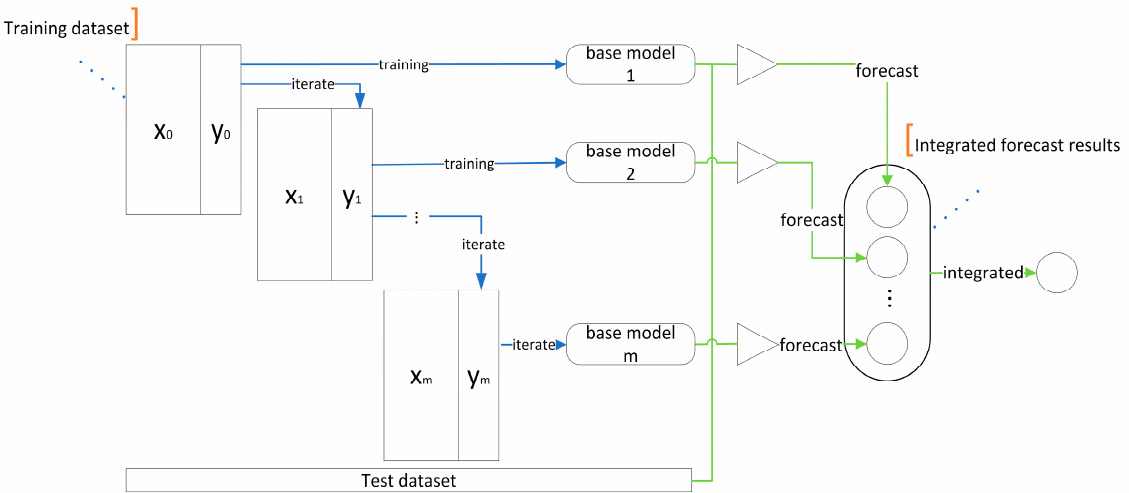
Figure 2. Description of boosting principle.